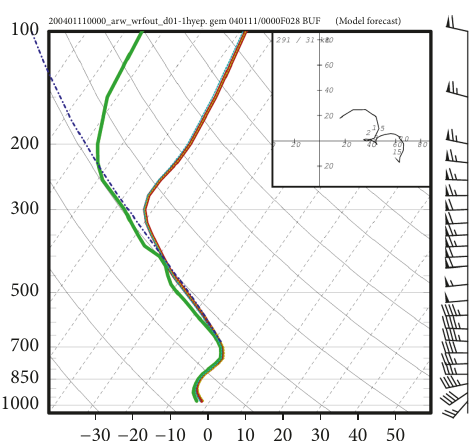
(b) As in Figure 13(a), except at 0400 UTC 12 January 2004 from an experimental, 13-km, hydrostatic WRF